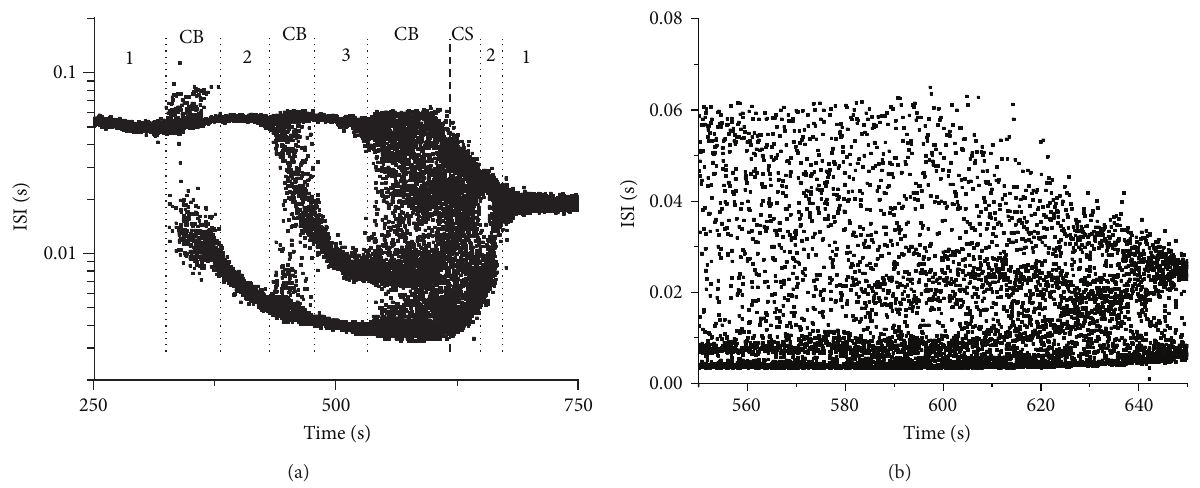
. (a) Bifurcation scenario from period-1 o